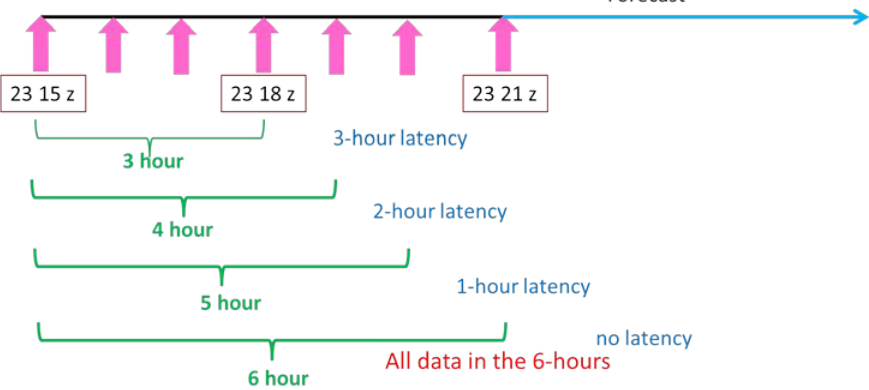
Figure 4. The flow chart of the assimilation and forecast experiments. The assimilation time was 1800 UTC 23 June. The green hours represent the available data time, and the blue represents the latency time.